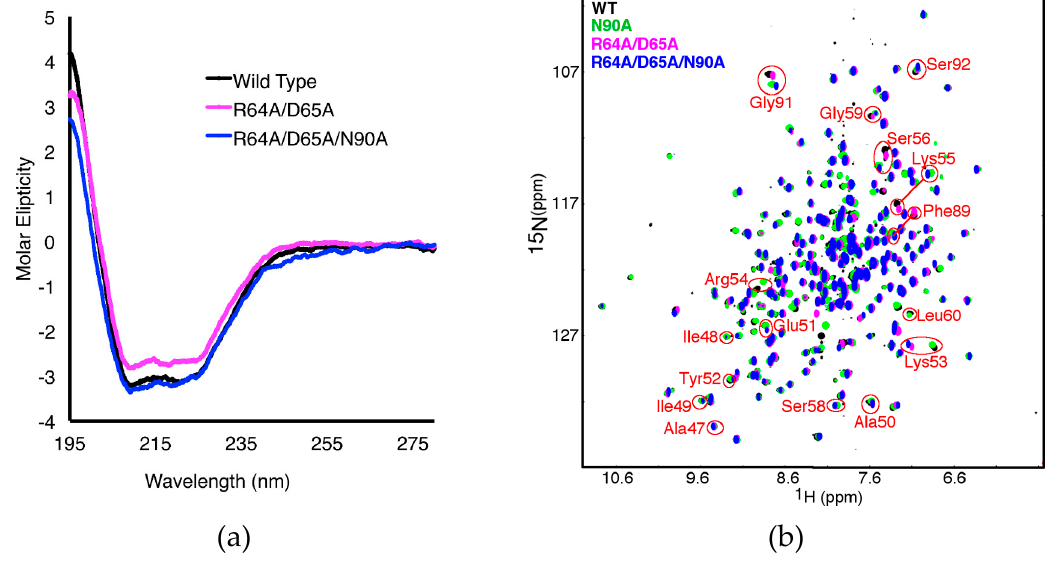
Figure 3. There are local, but not global, conformational changes induced by changing β 1 α 1 loop interactions. ( a ) CD spectra for WT (black), R64A/D65A (magenta) and R64A/D65A/N90A (blue) ssIGPS enzymes; ( b ) 1 H ‐ 15 N HSQC comparing WT (black), N90A (green), R64A/D65A (magenta) and R64A/D65A/N90A (blue) variants. Resonances highlighted include those of the β 1 strand (Ala47, Ile48, Ile49, Ala50, Glu51), the β 1 α 1 loop (Lys53, Arg54, Lys55, Ser56, Ser58, Gly59) and the β 2 α 2 loop (Phe89, Gly91 and Ser92). NMR data were collected at 310 K on samples containing ~1 mM protein in 25 mM potassium phosphate pH 7.0, 75 mM KCl, 1 mM EDTA, 1 mM DTT, 0.02% NaN 3 and 10% ( v / v ) 2 H 2 O.